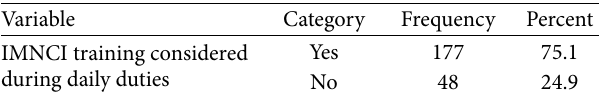
Table 4: IMNCI training considered during daily duties.